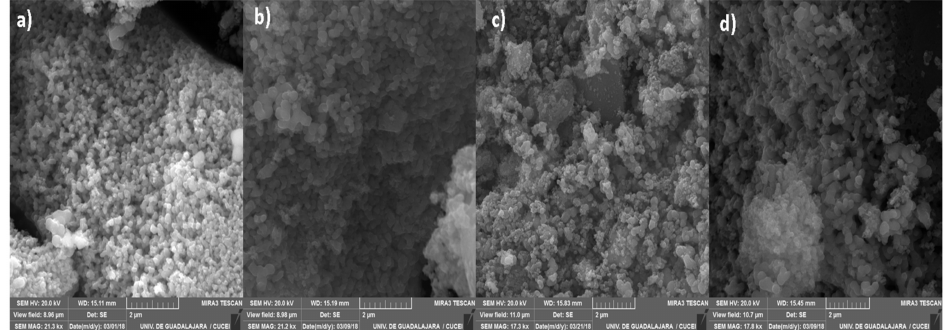
Figure 3. SEM micrographs of nanocomposites: ( a ) TiO 2 , ( b ) TZ-1, ( c ) TZ-3 and ( d ) TZ-5.